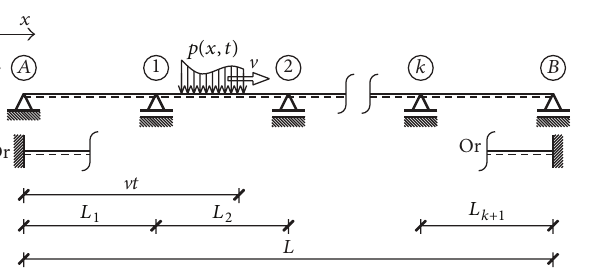
Figure 1: A multispan continuous beam subjected to a moving load.